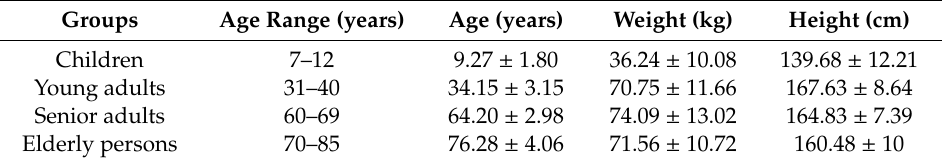
Table 1. Anthropometric